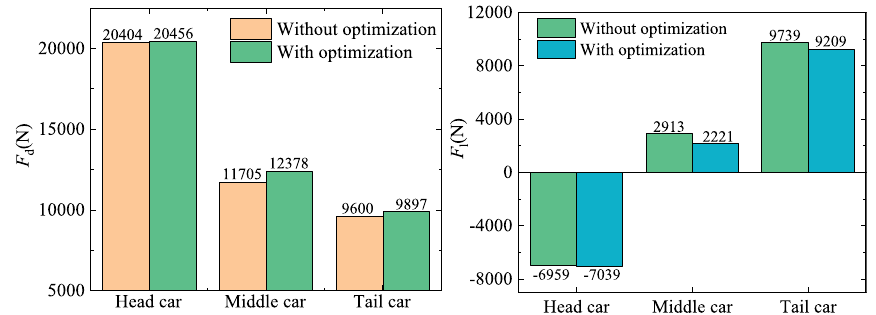
Fig. 16 The comparison results of aerodynamic ( a ) drag and ( b ) lift with or without braking